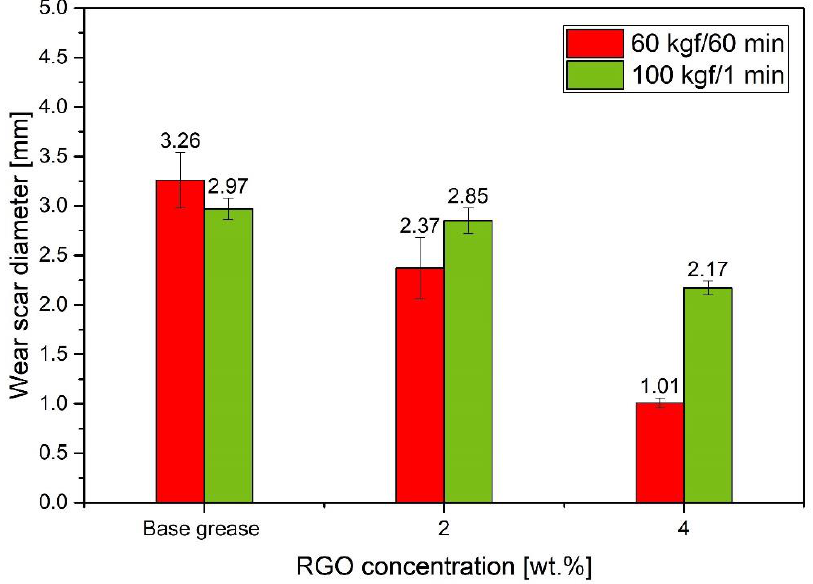
Figure 10. Average diameter of the wear scar of grease with RGO additive depending on the load (60 kgf for 60 min and 100 kgf for 1 min). (60 kgf for 60 min and 100 kgf for 1